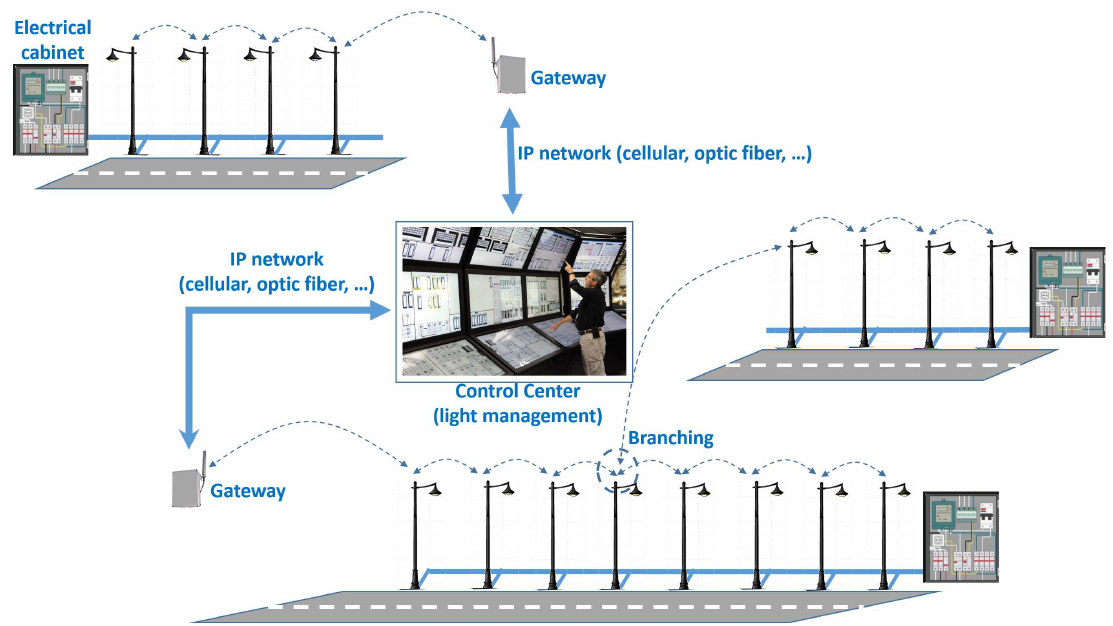
Figure 4. Bluetooth/IEEE802.15.4 mesh-based smart lighting